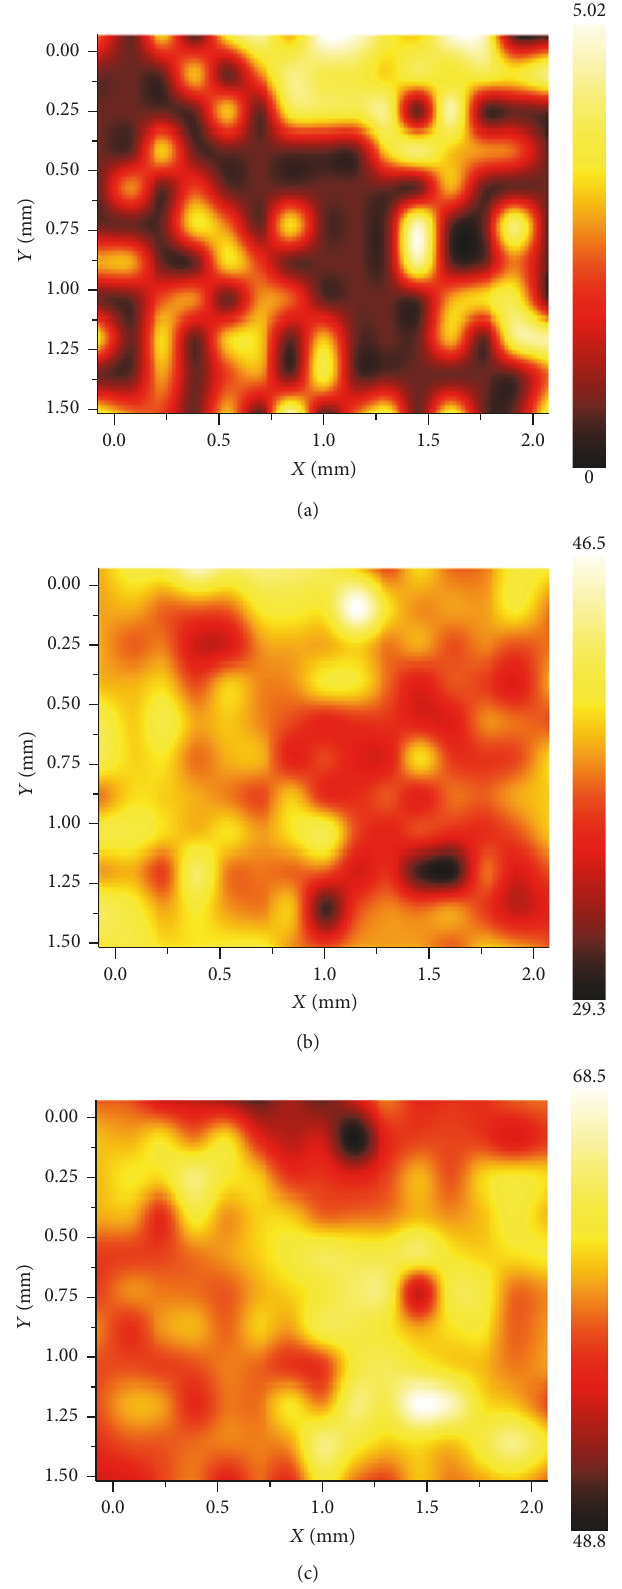
Figure 19: XPS maps for the atomic percentages of (a) Al2p; (b) O1s; and (c) Mg1s for the AZ91D alloy immersed for 72 h in 3.5 wt.% NaCl solution at room